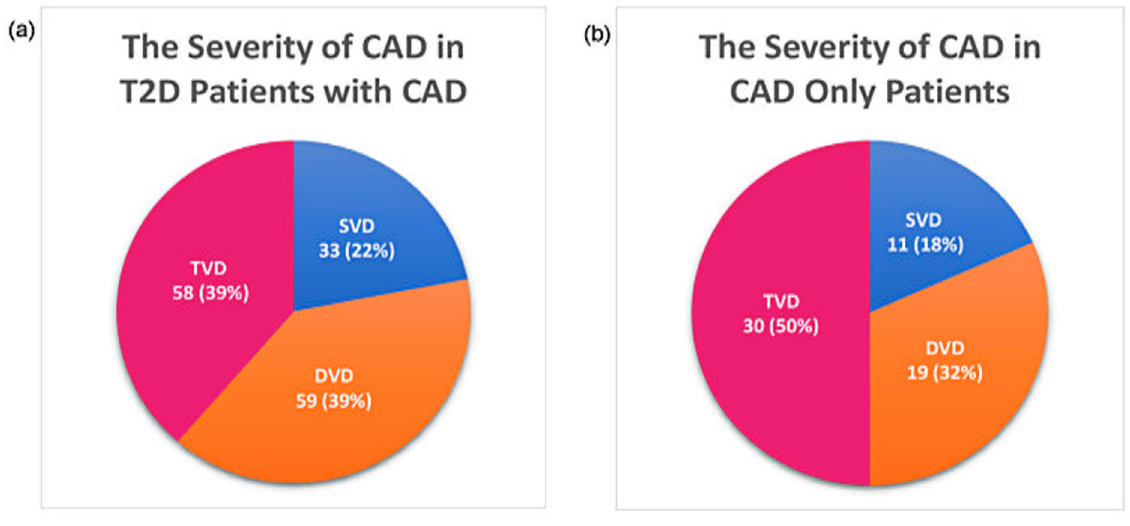
Figure 1. Distribution of patients according to the severity of CAD: ( a ) severity of CAD in T2D patients with CAD and ( b ) severity of CAD in CAD only patients.